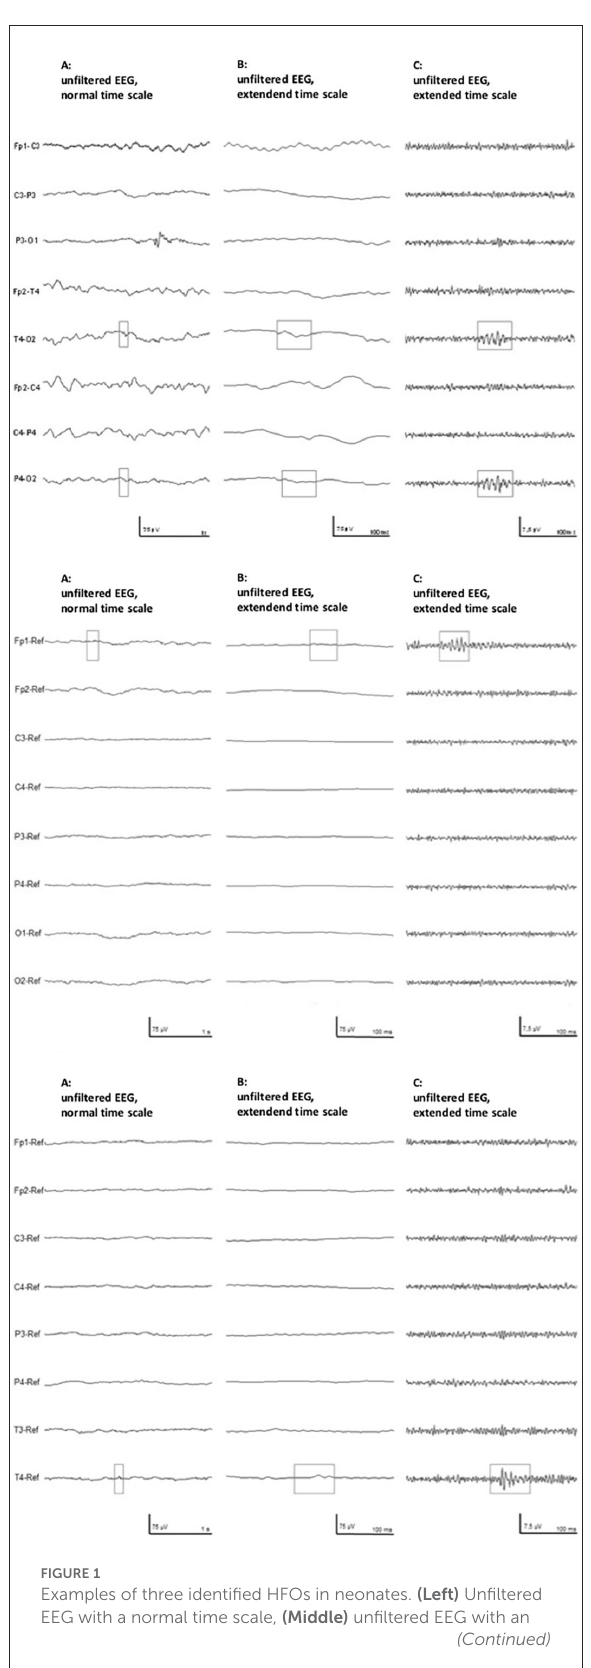
FIGURE1 Examples of three identified HFOs in neonates. (Left) Unfiltered EEG with a normal time scale, (Middle) unfiltered EEG with an